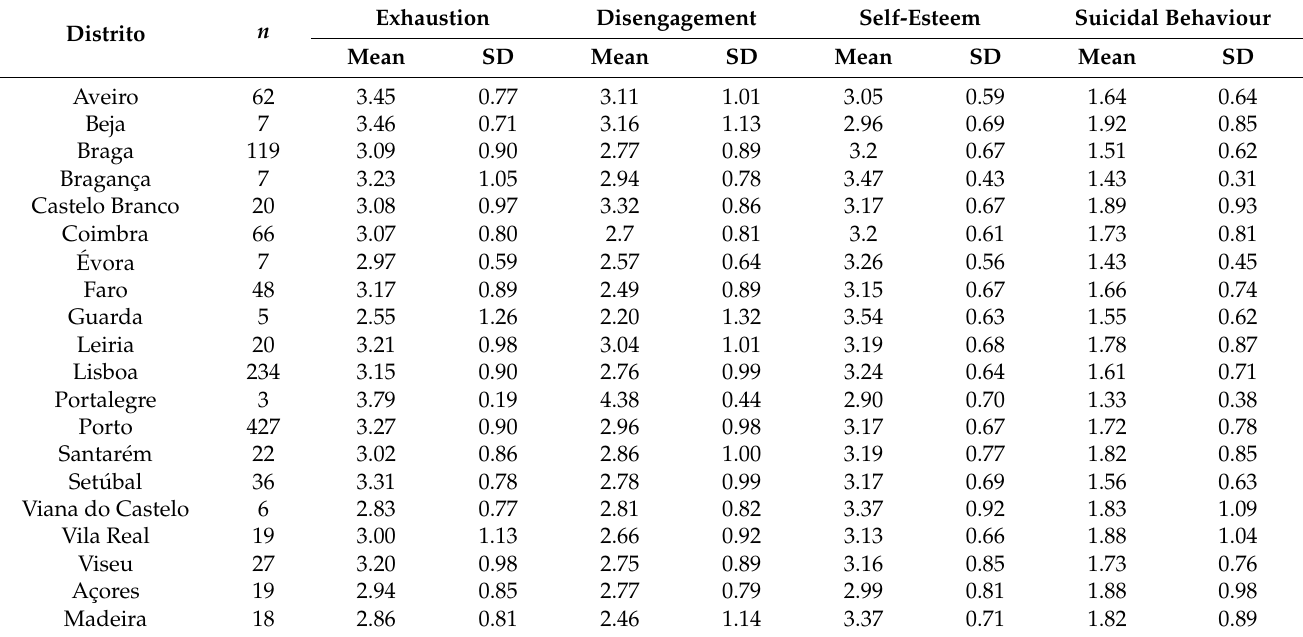
Table 3. Distribution of the variables under study according to Portugal’s district.